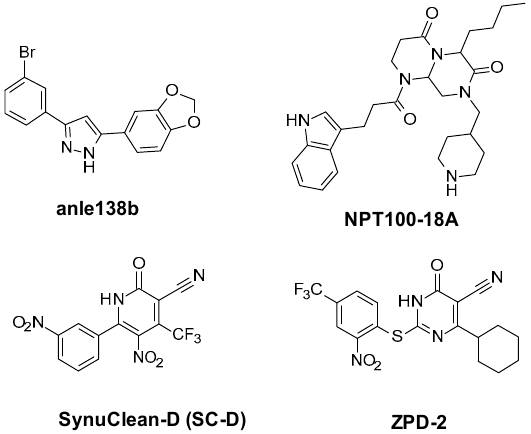
Figure 1. Chemical structures of Anle138b, NPT100-18A, SynuClean-D (also known as SC-D), and ZPD-2, well-known inhibitors of α -synuclein aggregation.